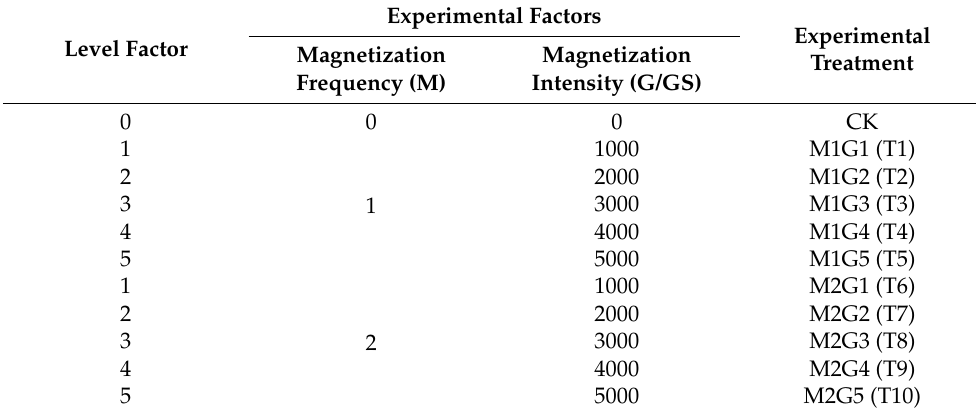
Table 2. Combination design of experimental scheme.